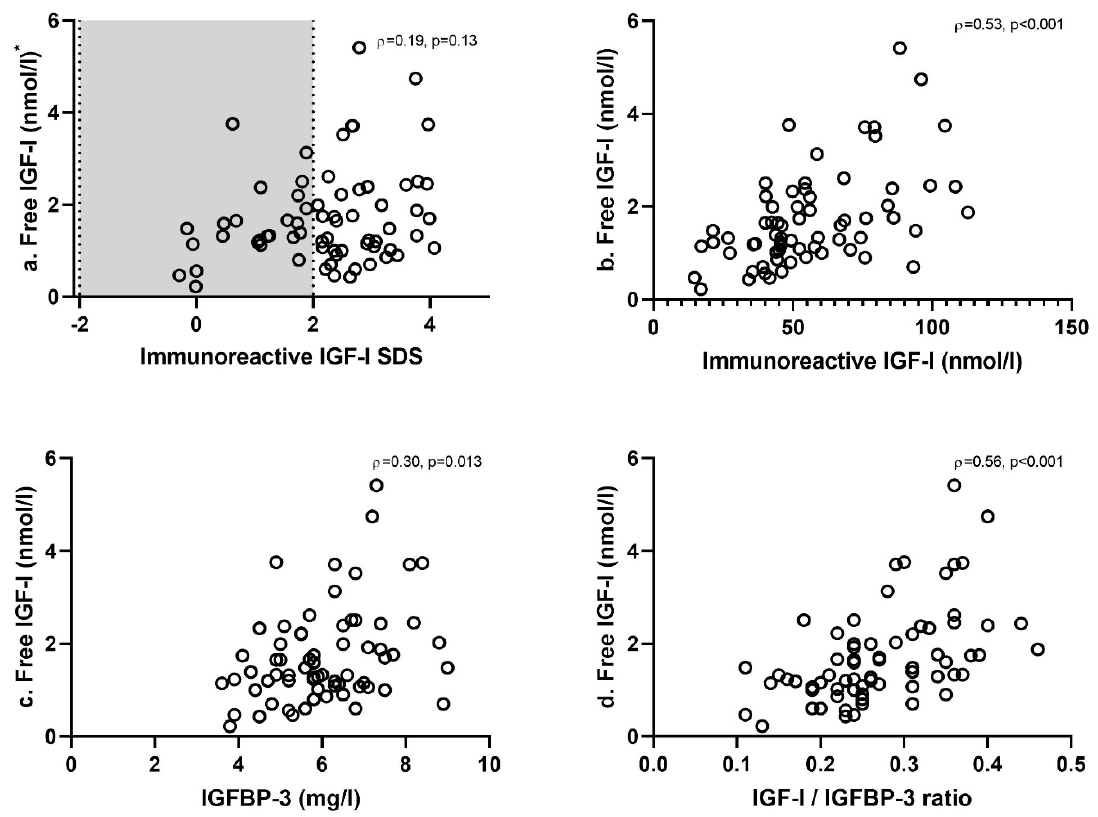
Figure 3. Correlations between free IGF-I and immunoreactive IGF-I, IGFBP-3 and IGF-I/IGFBP-3